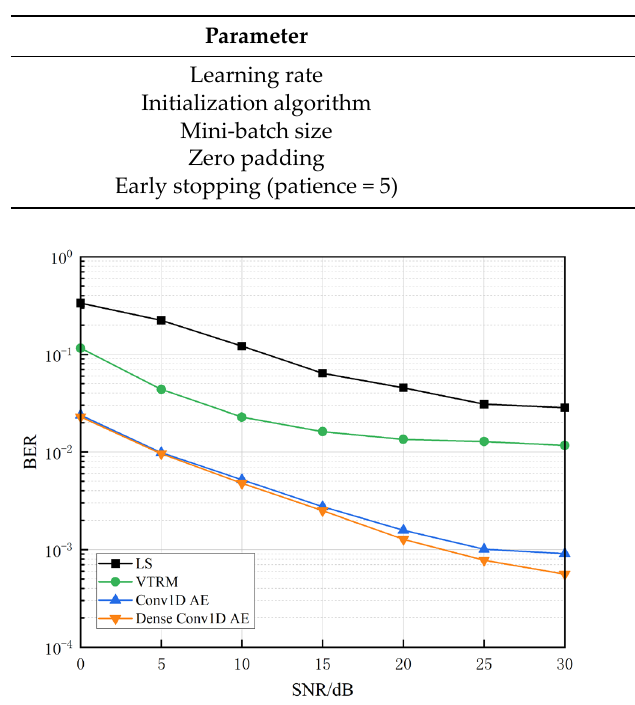
Figure 6. BER performance of dense convolutional autoencoder underwater acoustic communica‑